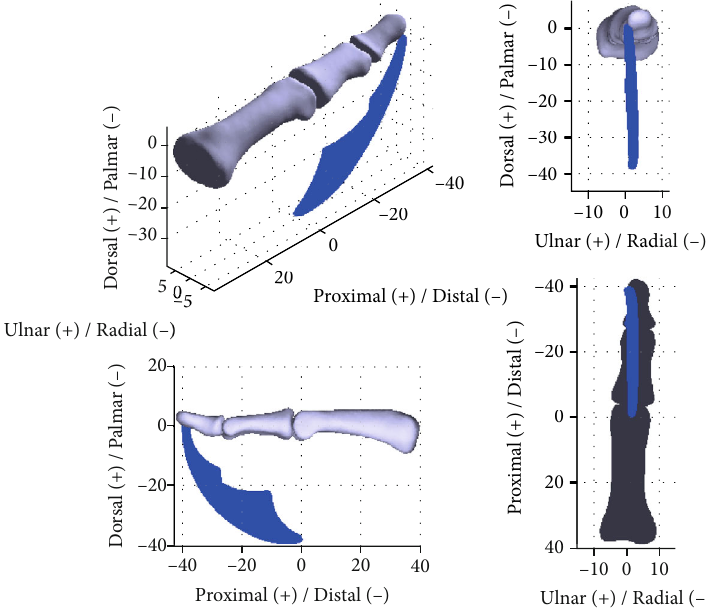
fi ed rotation axes of the PIP and DIP joints in an p g based on the identi